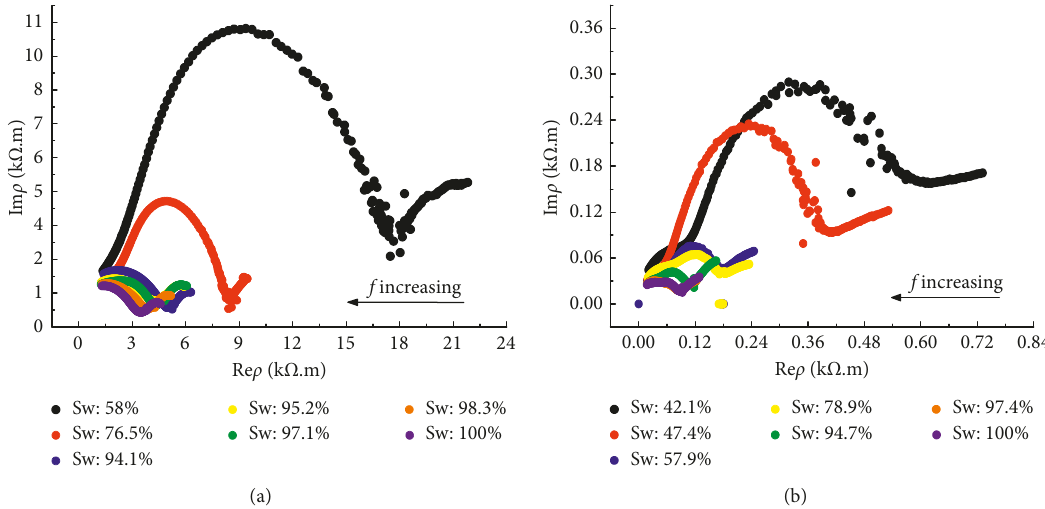
Figure 3: Re ρ -Im ρ dispersion curves of coal complex resistivity with different Sw: (a) bituminous coal; (b)